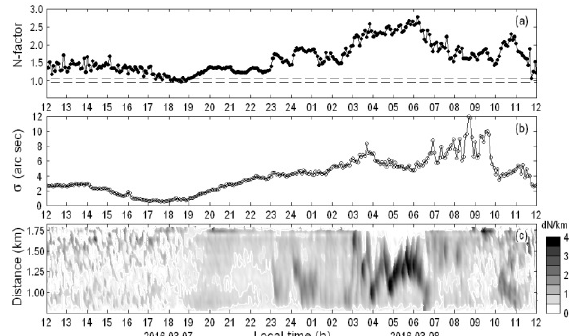
Fig. 5. Diurnal time series (a) of the integral backscatter amplification N- factor at a distance of 2 km, (b) variance of jitter of the disk image centroid at the 2-km path, and (c) range-time distribution of the derivative of the BSA factor. The correlation coefficient is equal to 0.65. Record from 12am of March 7 of 2016 to 12am of March 8 of